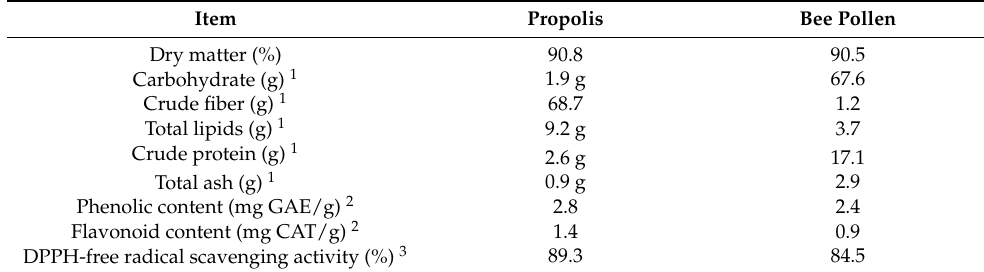
Table 1. The chemical characteristics of propolis and bee